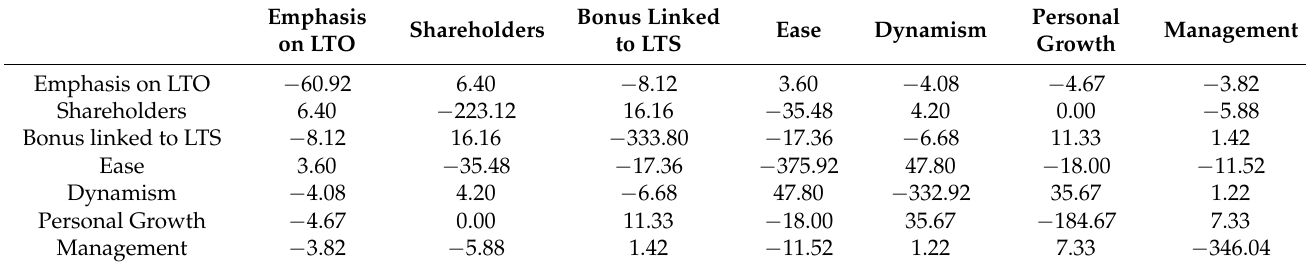
Table 3. Covariance matrix.